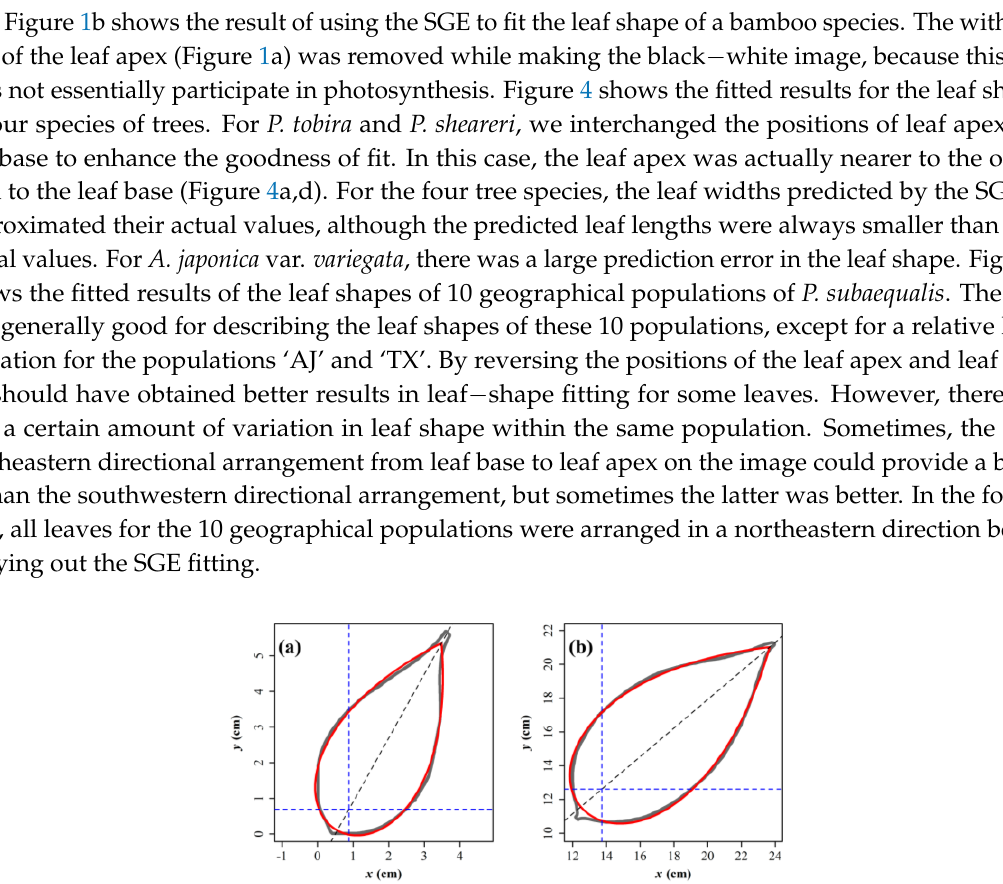
Figure 5. Fitted results using the SGE for the 10 geographical populations of P. subaequalis . AJ: Anji, Zhejiang Province; HN: Xinyang, Henan Province; HW: Huangwei, Yuexi, Anhui Province; HZ: Changhua, Huangzhou, Zhejiang Province; JD: Jingde, Anhui Province; JS: Yixing, Jiangsu Province; SC: Shucheng, Anhui Province; TC: Tongcheng, Anhui Province; TT: Tiantangzhai, Jinzhai, Anhui Province; TX: Tianxia, Yuexi, Anhui Province. For every panel, the gray curve represents the scanned (observed) leaf edge, and the red curve represents the leaf edge predicted by the SGE. The leaves correspond to those in Figure 3. We further evaluated the model’s validity by comparing the scanned and predicted leaf areas based on the SGE (Figure 6a–i). For standard leaves of 42 bamboo species, the theoretical leaf length (predicted by the SGE) was estimated to be 4.76% smaller than the actual value (represented by the scanned leaf length), and the corresponding MPE between scanned and predicted LA was 6.77% (Figure 6a). The intercept of the linear regression equation was equal to 0.0969 and statistically insignificant ( p = 0.139). For four bamboo species of Indocalamus , the theoretical leaf length was predicted to be 0.38% smaller than the actual value, and the corresponding MPE was lower than 5% (Figure 6b). The intercept of the linear regression equation was equal to 0.9602 and statistically significant ( p < 0.01). For B. multiplex f. fernleaf , the theoretical leaf length was predicted to be 8.07% smaller than the actual value, and the corresponding MPE was lower than 5% (Figure 6c). The